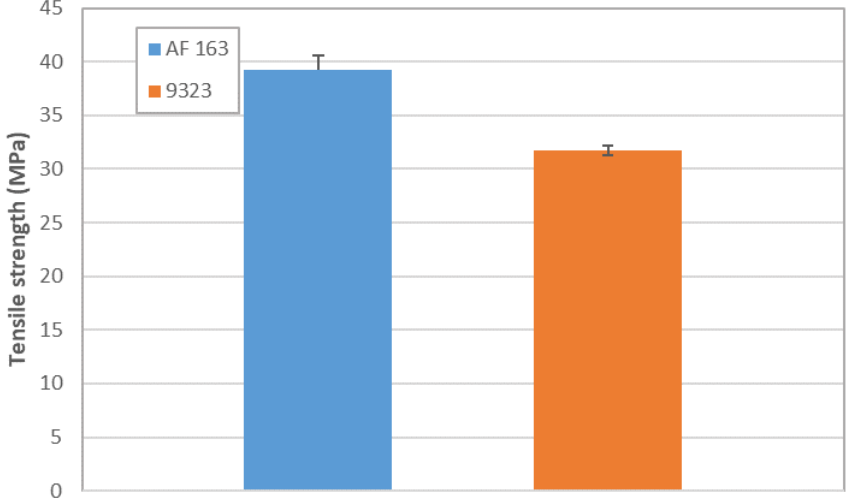
Figure 26. Overlap shear strength from the SLJ